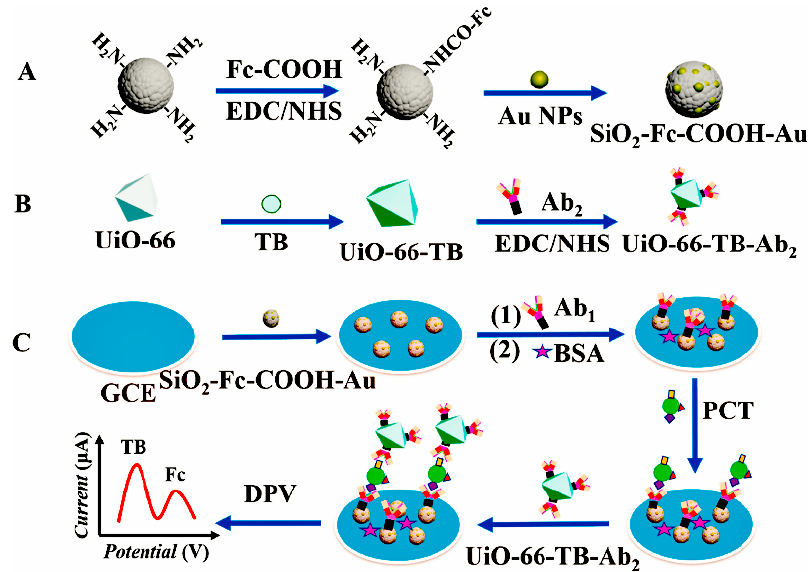
Figure 4. Immunosensor preparation mechanism diagram. ( A ) the preparation of SiO 2 –Fc–COOH– Au. ( B ) the preparation of UiO–66–TB–Ab 2 ( C ) the preparation of the electrochemical immunosensor [74]. Copyright (2021) Elsevier.